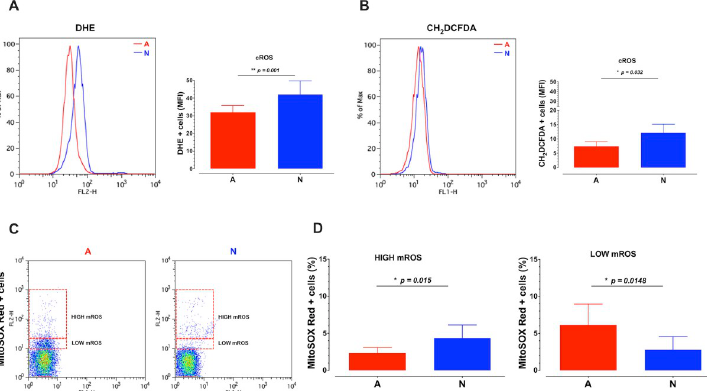
Fig 1. Neonatal CD8 + T cells have higher basal cROS and mROS levels than their adult counterparts. Purified human CD8 + T lymphocytes from neonate (N) or adult (A) donors were incubated with 2 μ M of DHE (A), or 10 μ M of Carboxy-H 2 DCFDA (B) or 2.5 μ M of the MitoSOX Red (C, and D) fluorescent dyes for 15 minutes. The fluorescence of the cells was assessed using a FACScalibur Flow Cytometer. The graphs show the fluorescence of the cells on the FL-2H channel (DHE, MitoSOX Red) or FL-1H channel (CH 2 DCFDA). Five to nine samples per group are shown. An unpaired Mann-Whitney test was used for comparisons between samples from N and A. The p-value is presented for each